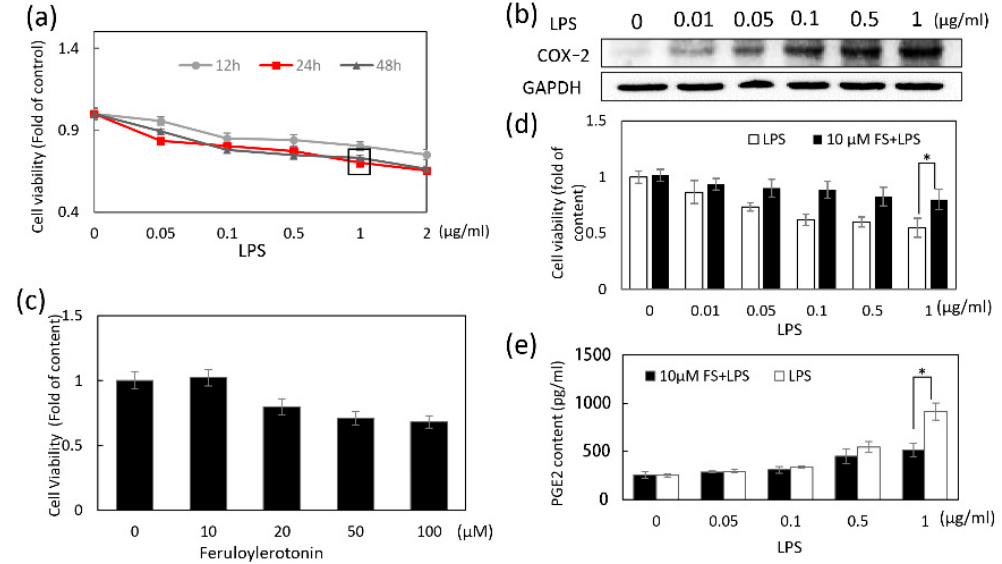
Figure 1. The e ff ects of lipopolysaccharides (LPS) and feruloylserotonin (FS) on HaCaT Figure 1. The effects of lipopolysaccharides (LPS) and feruloylserotonin (FS) on HaCaT cells. Cell viability was analyzed by MTT (3-(4,5-dimethylthiazol-2-yl)-2,5-diphenyltetrazolium bromide). ( a ) HaCaT cells were treated with 0–2 µg/mL LPS for 12, 24, and 48 h. ( b ) COX-2 levels in 0–1 µg/mL LPS-induced HaCaT cells were detected with Western blotting. ( c ) The HaCaT cells were treated with 0–100 µM FS for 24 h. ( d ) The cell viabilities in only LPS group and FS-LPS group were compared under the treatment of 0 to 1 µg/mL LPS. ( e ) The released prostaglandin E2 (PGE 2 ) levels in only LPS group and FS-LPS group were measured with the prostaglandin E 2 assay kit. * p -value < 0.05.